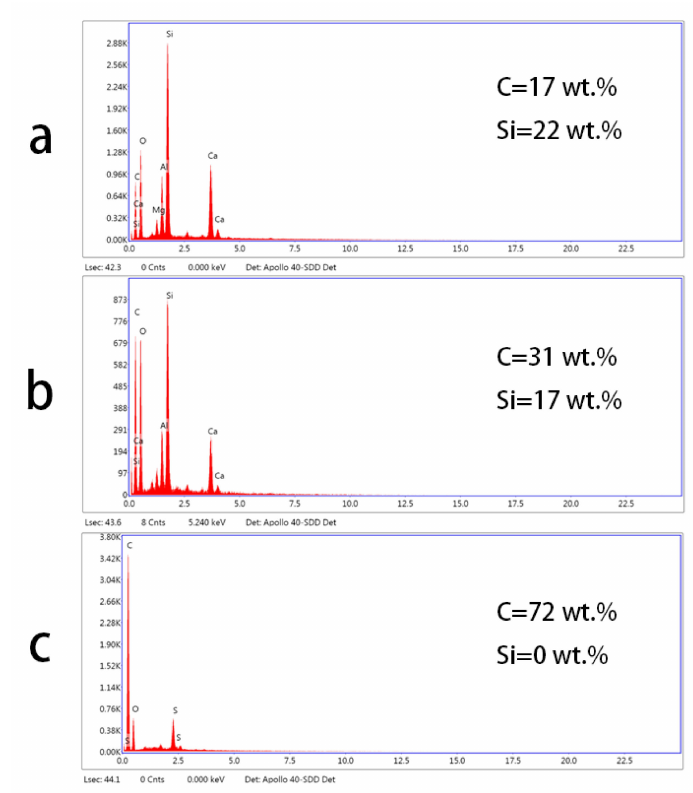
Figure 8. EDS analysis of worn surface: ( a ) Raw GFRP, ( b ) I-0.4 g, ( c ) C-0.4 g.